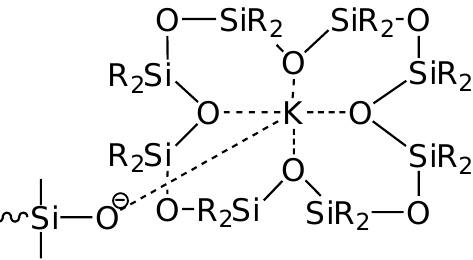
Figure 4. Metal coordination by oxygen atoms of the cyclosiloxane molecule.